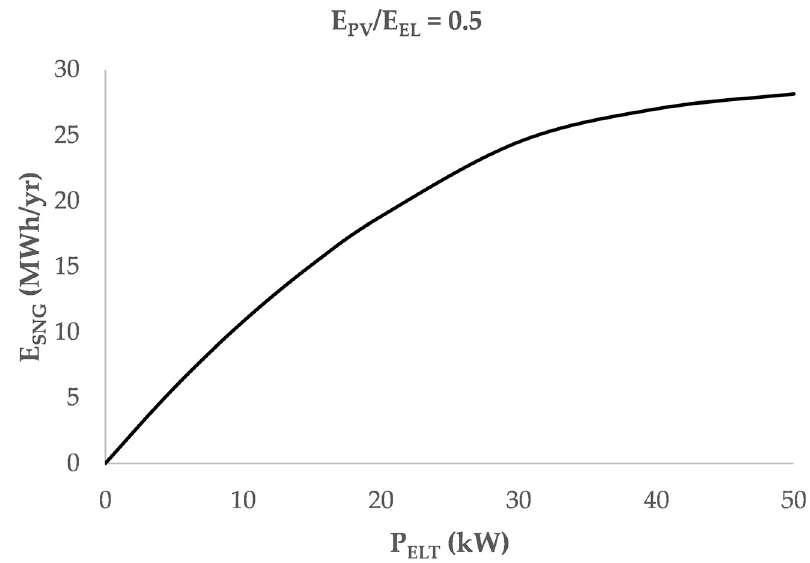
Figure 5. Annual SNG production, expressed by MWh/yr, versus the rated power of electrolyser in the scenario E PV /E EL equal to 0.5.